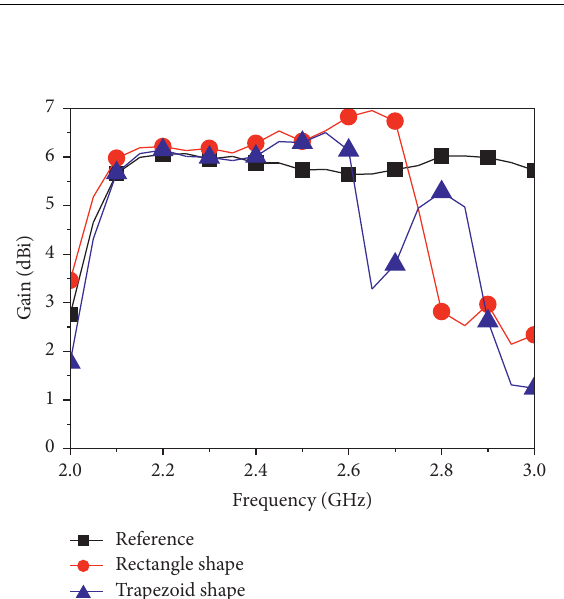
Figure 13: Simulated results of 2D gain versus frequency comparison of the presented